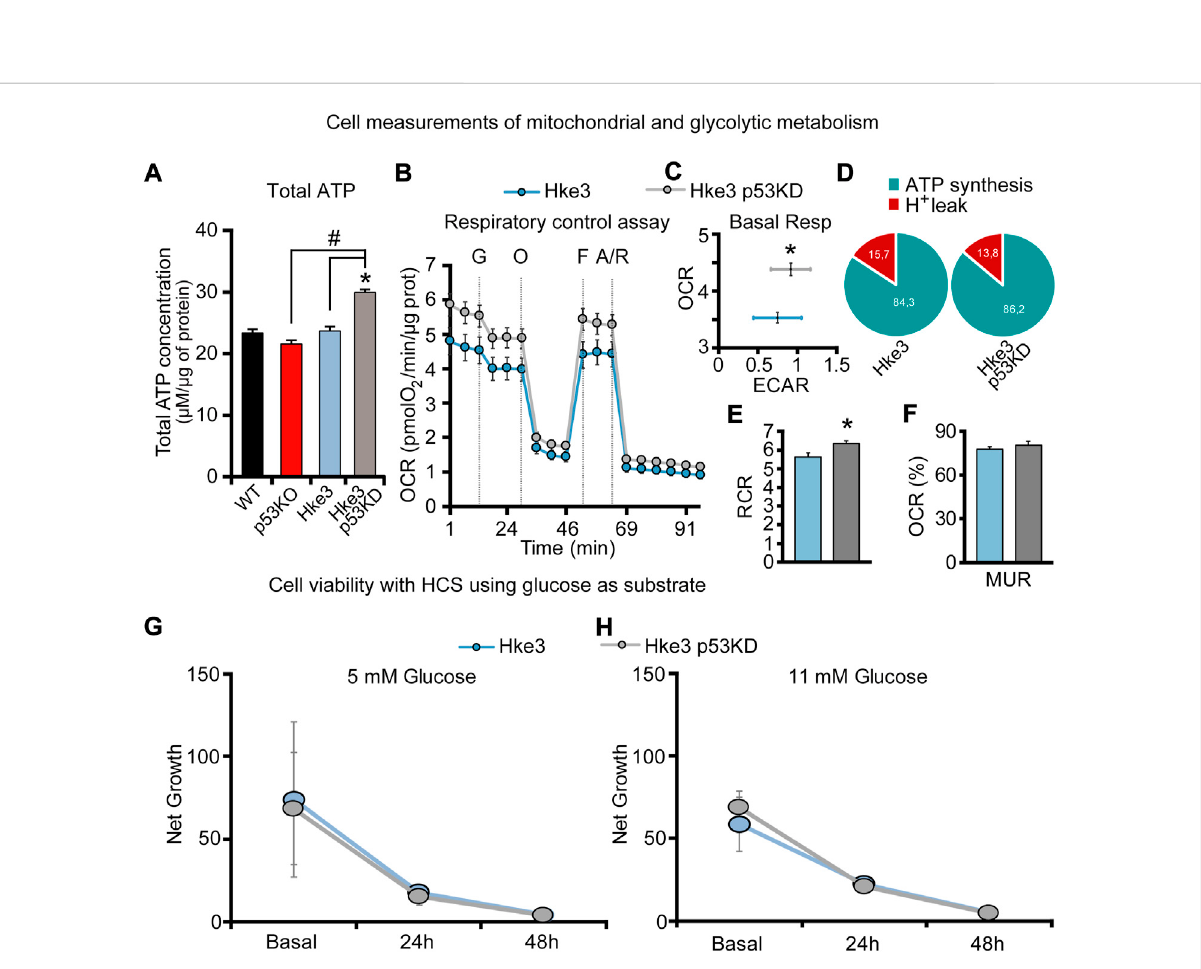
FIGURE 3 TP53 -silenced Hke3 cells with a competent KRAS display higher basal respiration and tightly-coupled mitochondria. (A) Total ATP concentrationnormalizedtomicrogramsofproteinsforeachcelllineafter80 minofnutrientsstarvation.Alldataareexpressedasmean±SEMfrom experimental triplicates and three independent cultures. * p ≤ 0.05 compared to WT control cells; # p ≤ 0.05 between cell lines (ANOVA, post-hoc Tukey). (B – F) Cellular oxygen consumption rate (OCR) and extracellular acidi fi cation rate (ECAR) were measured in Hke3 and Hke3 p53 KD cultured cells in ambient O 2 concentrations using a Seahorse XF96 Extracellular Flux Analyzer. Sequential injection of substrate (10 mM glucose, G) and metabolic inhibitors Oligomycin (O, 3 μ M), FCCP (F, 0.5 μ M) and Antimycin/Rotenone (A/R, 1 μ M/1 μ M) was performed at the indicated times (dashed lines) and enabled determination of bioenergetic parameters. Bioenergetic pro fi les (B) and basal OCR and ECAR (C) are represented. ATP synthesis and proton (H + ) leak parameters were calculated (D) and the ratio represented as respiratory control rate (RCR; E). Basal respiration was calculated subtracting non-mitochondrial respiration from OCR after the initial stabilization (third measurement), and it was considered 100%. The percentage of maximal uncoupled respiration (MUR; K) in basal state (non-stimulated conditions) were calculated in relation to basal OCR and determined in the presence of glucose. All data represent mean values ±SEM from four independent experiments from a total of 26 – 52 wells. OCR and ECAR were normalized to micrograms of protein in each monitored well. * p < 0.05 compared to Hke3 cells (Student ’ s t test). (G,H) Cell net growth (calculated as the ratio of the number of living/proliferating cells (Hoechst 33,588) and dead cells (PI) for Hke3 (in blue) and Hke3 p53 KD (in grey) cultured cells in RPMI with 5 mM (G) and 11 mM (H) glucose. ( p ≥ 0.05; ANOVA, post-hoc Tukey).